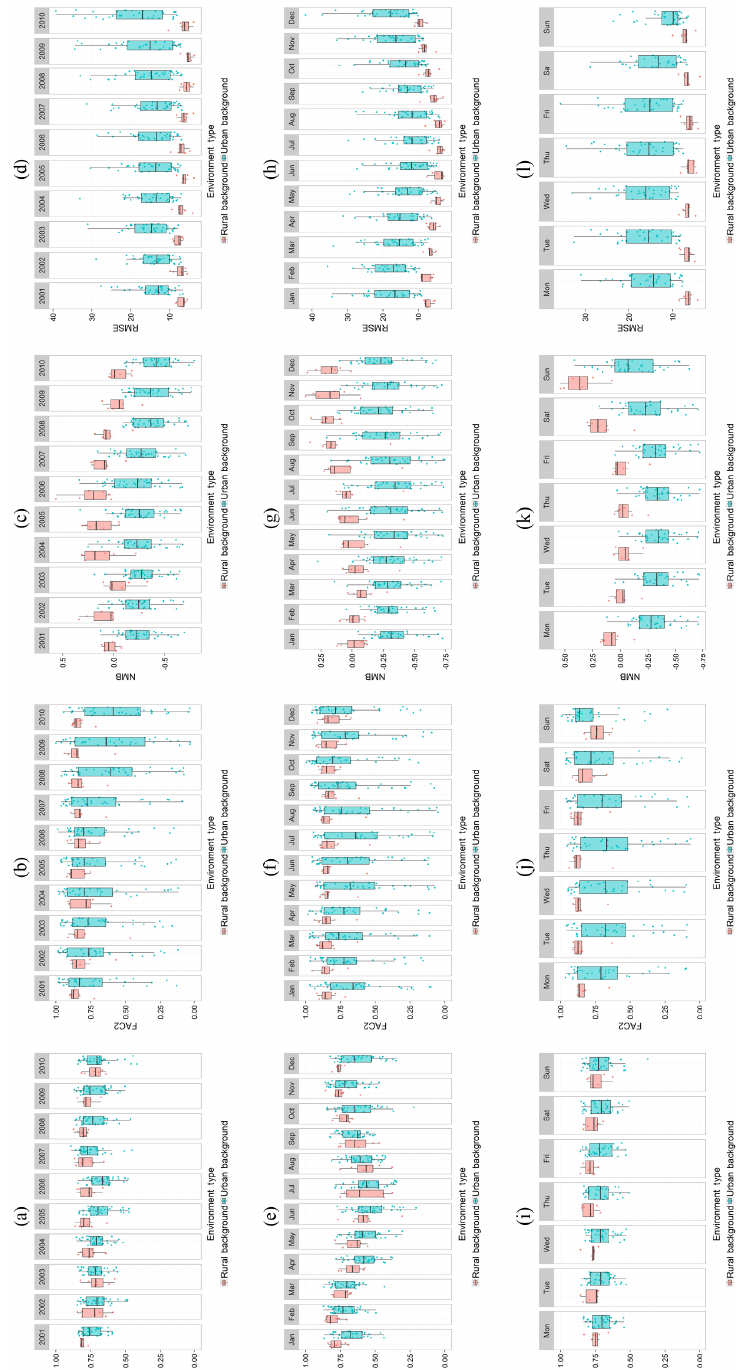
Figure 2. Model–measurement statistics per site for NO 2 daily mean concentrations during 2001–2010, by site type, and by (a–d) year, (e–h) month-of-year, and (i–l) day-of-week. (a) , (e) , and (i) are Pearson’s correlation coefficient ( r) ; (b) , (f) , and (j) are the fraction of data pairs within a factor of 2 (FAC2); (c) , (g) , and (k) are normalized mean bias (NMB); and (d) , (h) , and (l) are the root mean squared error (RMSE) in µgm − 3 . Dots show individual site statistics ( n = 7 and 37 for RB and UB sites, respectively), which are summarized in the superimposed box plot whose shading demarcates the interquartile range (IQR) and whose whiskers extend to the largest and smallest values within 1.58 × IQR from the box